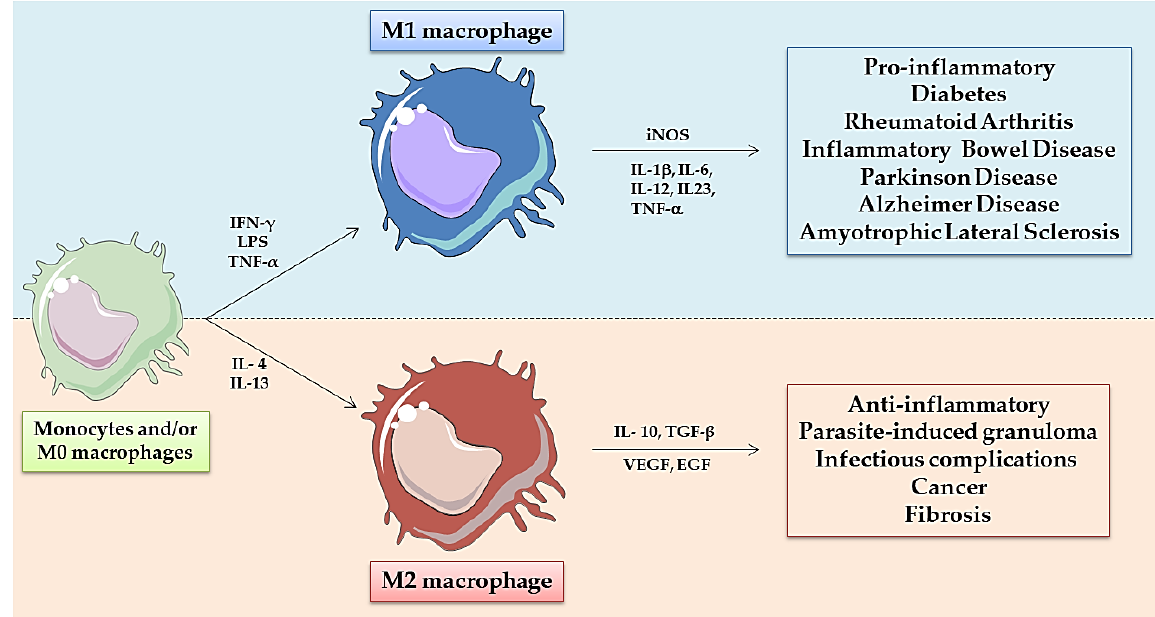
Figure 1. Macrophages originate from monocytes or tissue-resident macrophages. In response to different microenvironmental stimuli macrophages polarize towards an M1-like or M2-like phenotype, and the excessive accumulation of macrophages with a particular phenotype has been correlated with a poor prognosis in some diseases (on the right). In pathological tissues, these macrophages frequently contribute to the development and progression of the disease, thus their reprogramming towards an opposite polarization status has been recognized as an important therapeutic strategy.